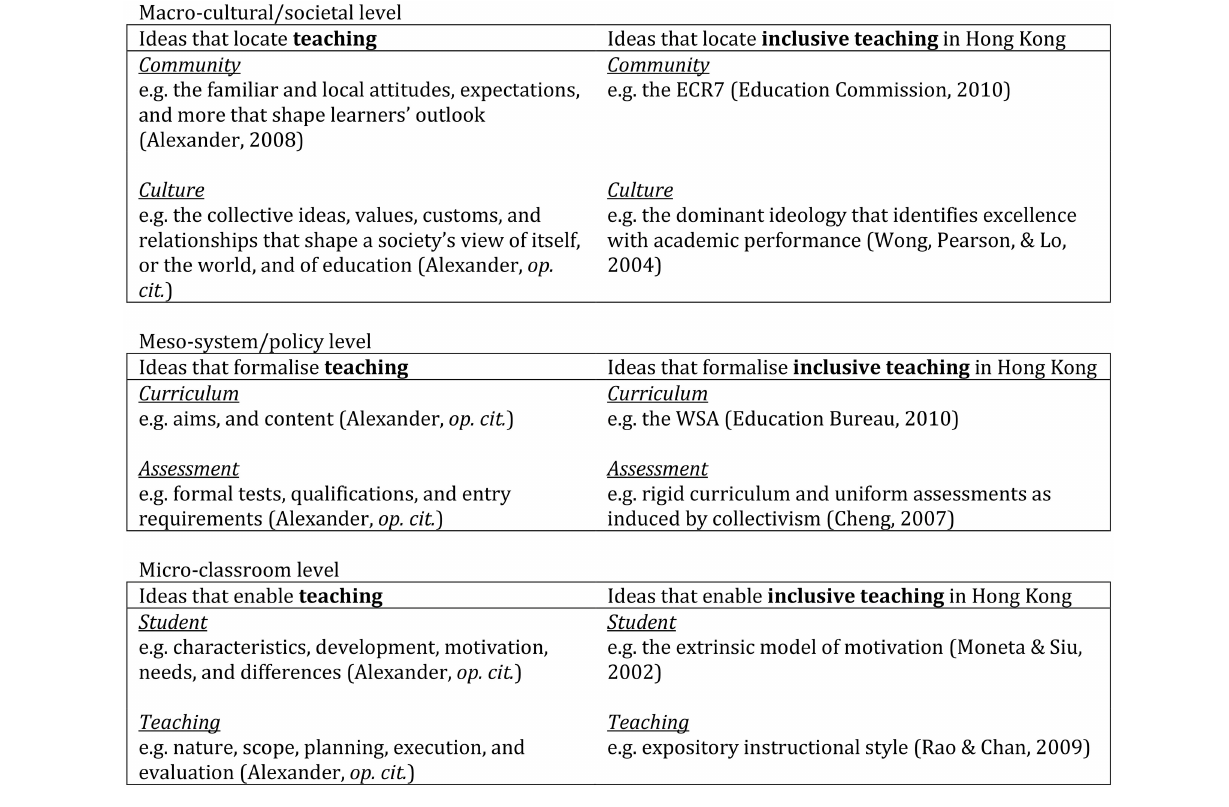
FIGURE 1 | Exploring inclusive pedagogy in Hong